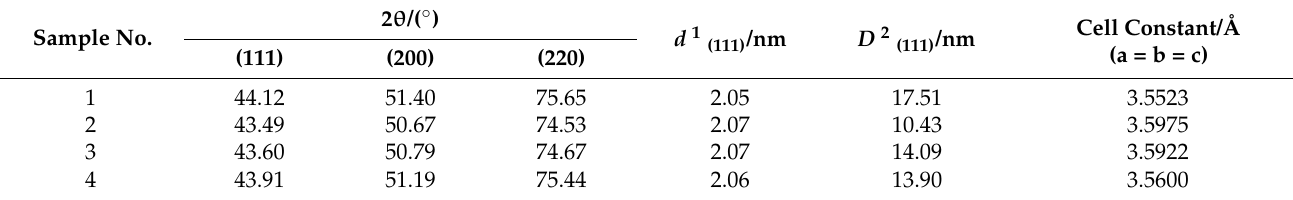
Table 2. Detailed value of the diffraction peaks and the calculated